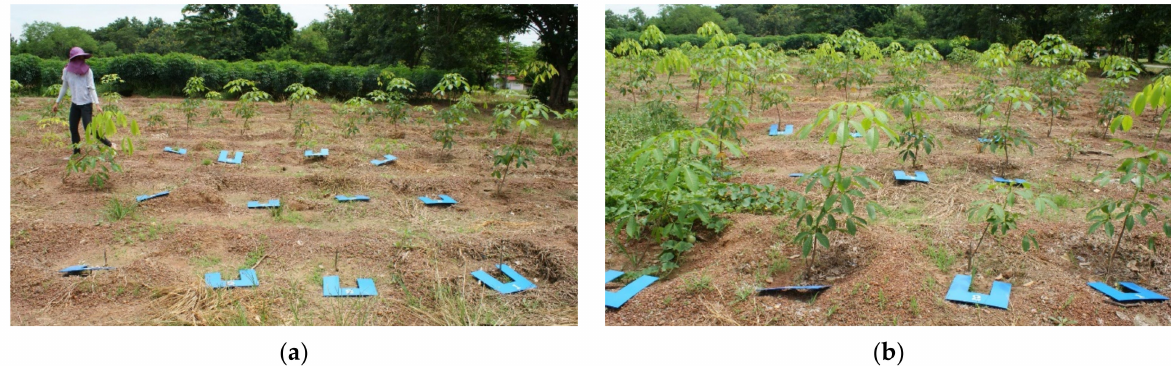
Figure 9. ( a ) A picture of rubber trees taken from one block of control treatment after 6 months, without watering; ( b ) a picture of rubber trees taken from one block of SWA treatment after 6 months, without